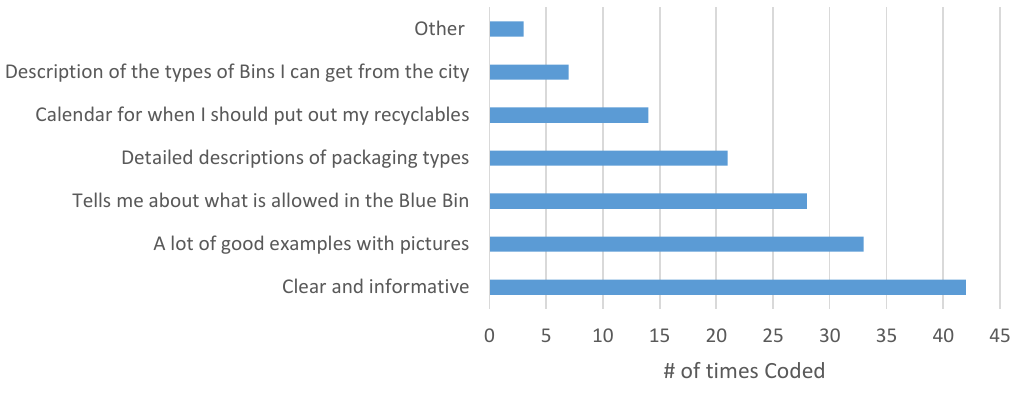
Figure 17. Coded Responses to P&E Web Resources (Clarity).